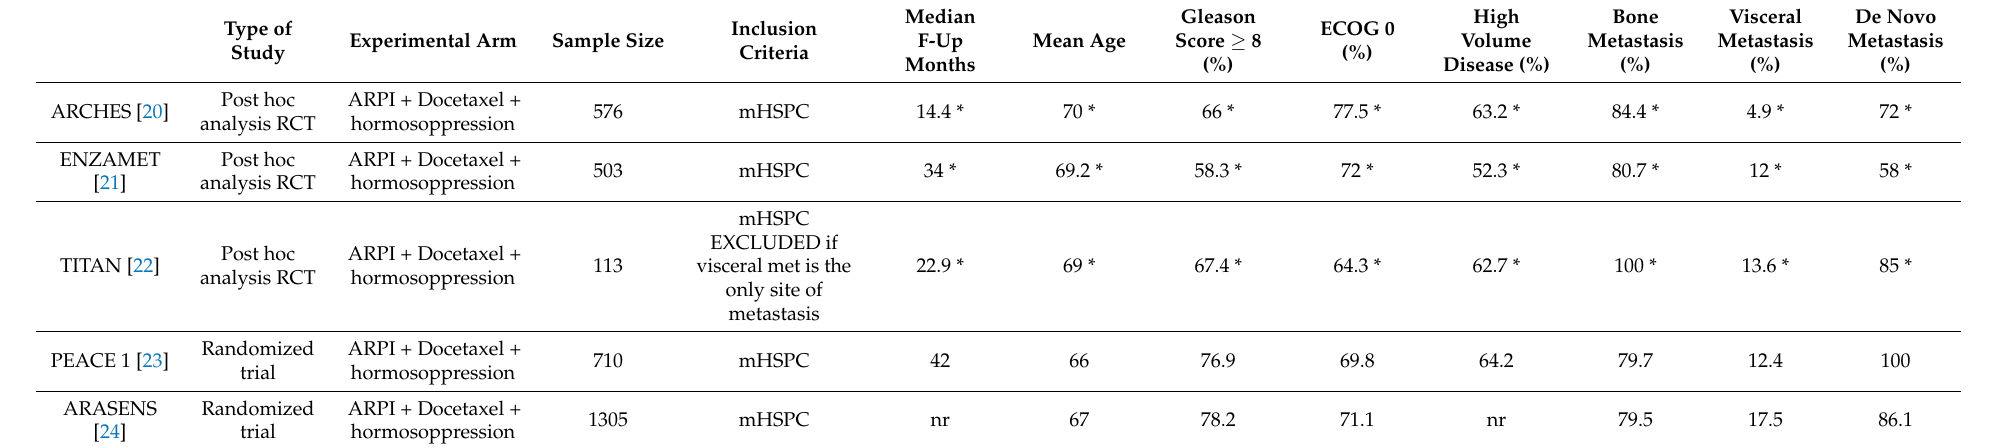
Table 1. Study- and patient-level characteristics of the studies in the